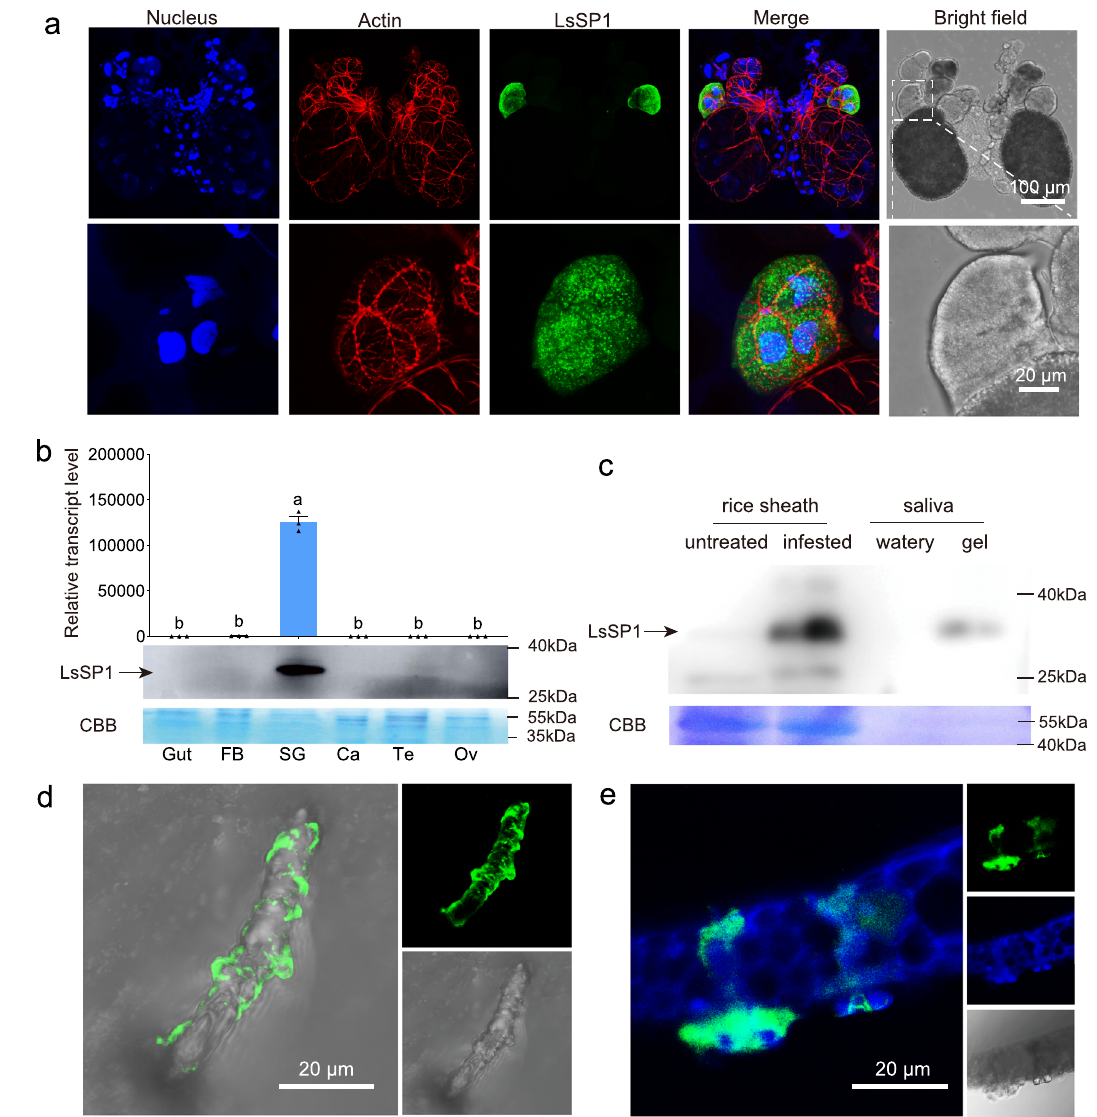
Fig. 2 | LsSP1 is a salivary sheath protein and secreted into plants. a Immunohistochemical staining of LsSP1 in salivary glands. L. striatellus salivary glands were incubated with anti-LsSP1 serum conjugated with Alexa Fluor ™ 488 NHSEster (green) and actin dye phalloidinrhodamine (red)and examined by Leica SP8. The nucleus was stained with DAPI (blue). The lower images represent the enlarged images of the boxed area in the upper image. The boxed area was indi- cated in bright fi led image. b Expression patterns of LsSP1 in different tissues quanti fi edbyqRT-PCR(upper)andwestern-blotting(lower)assays.FBfatbody,SG salivary gland,Ca carcass, Tetestis, Ov ovary. Data are presented as meanvalues ±